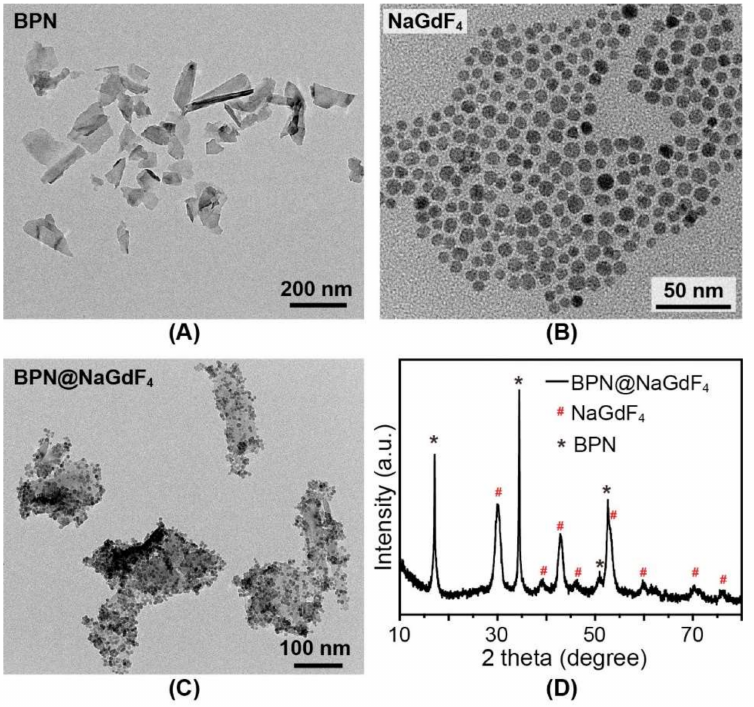
Figure 2. The TEM images of BPN ( A ), NaGdF 4 ( B ), and BPN@NaGdF 4 ( C ); ( D ) XRD pattern of the as-synthesized BPN@NaGdF 4